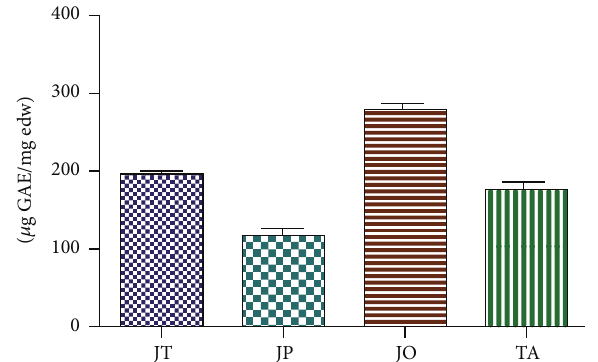
Figure 1: Total polyphenol content expressed as gallic acid equiva- lents( 𝜇 gGAE)/mgplantextractin J.thurifera (JT), J.oxycedrus (JO), J.phoenicea (JP),and T.articulata (TA)infusions.Dataareexpressed as mean ± SD ( n = 3).